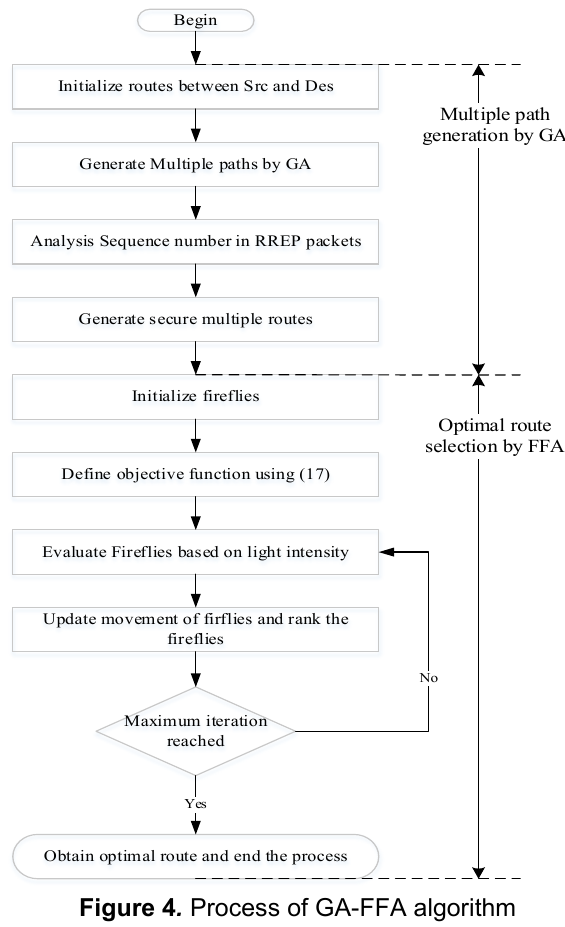
Figure 4 . Process of GA-FFA